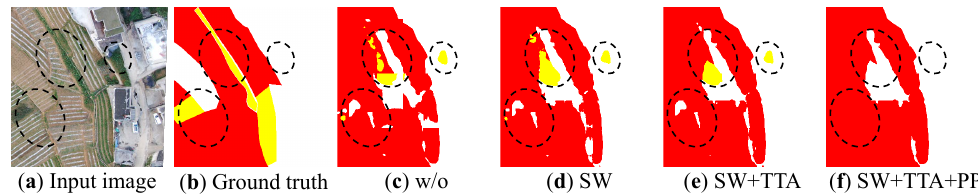
Figure 13. Improvements by adding Overlapping Slide Window (OSW), Testing Time Augmentation (TTA), and the Post-Processing (PP) method of removing small objects and